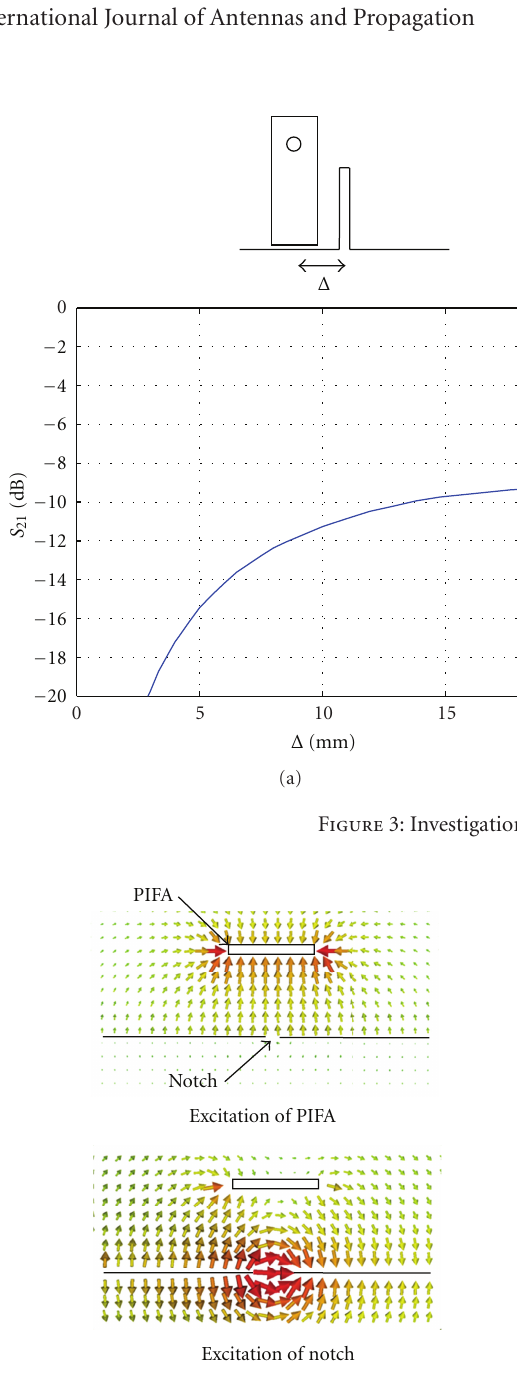
Figure 4: Electrical fields in open end ( π